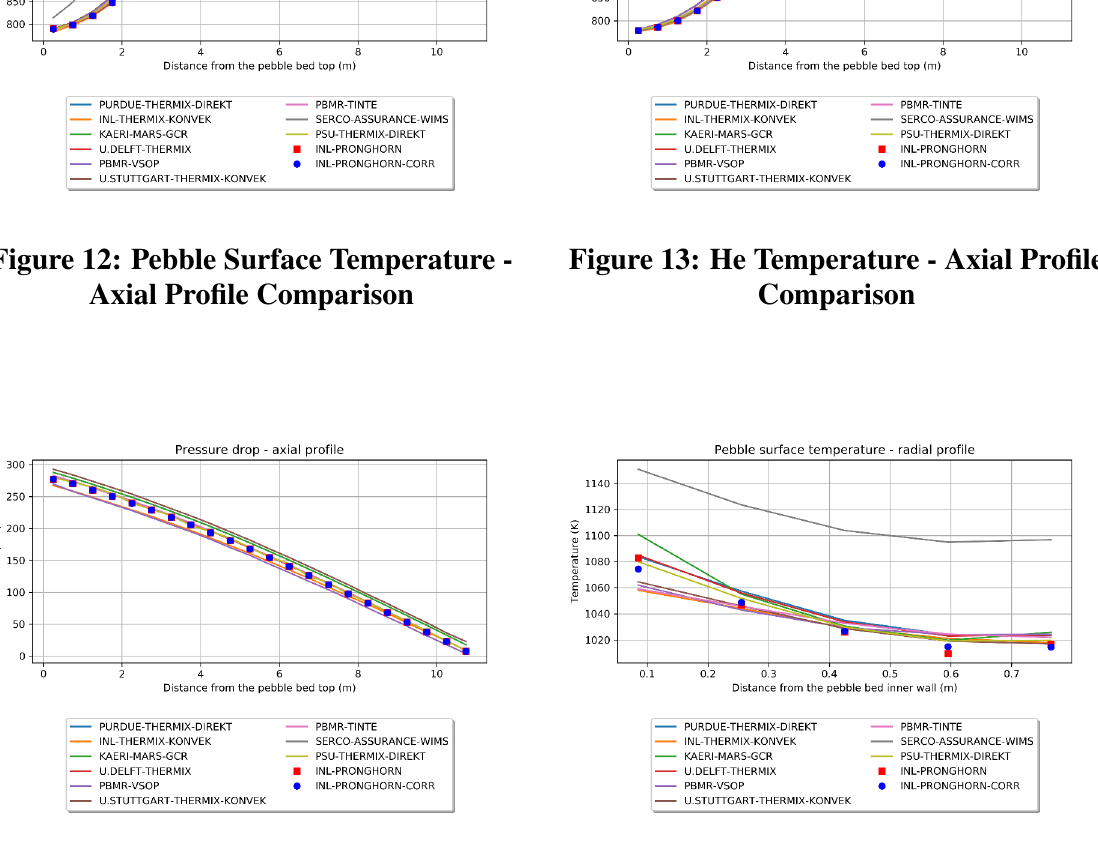
Figure 15: Pebble Surface Temperature - Radial Profile